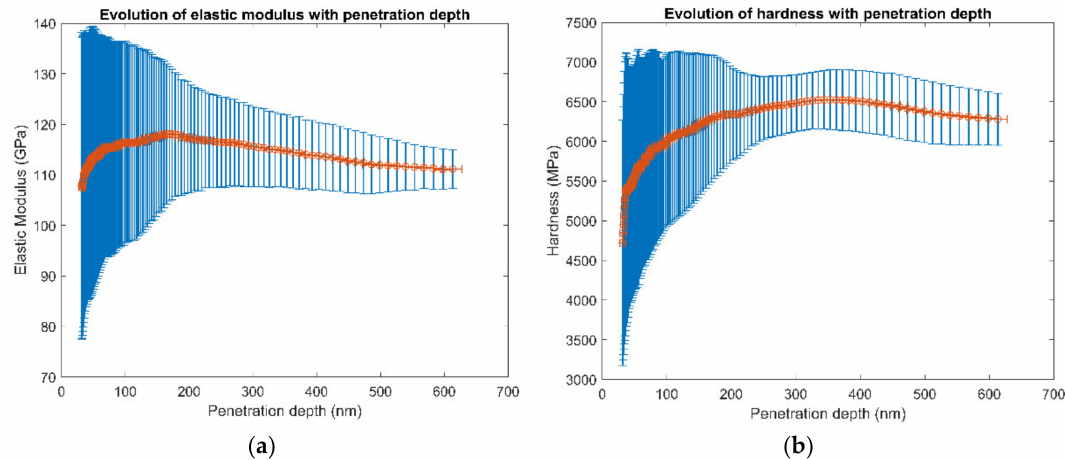
Figure 11. Loading-unloading indentation curves with maximum load of 45 mN for the samples consolidated by SPS at 750 ◦ C (blue) and 1000 ◦ C (red).